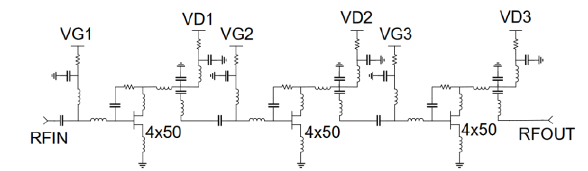
Figure 17: Schematic of LNA Design